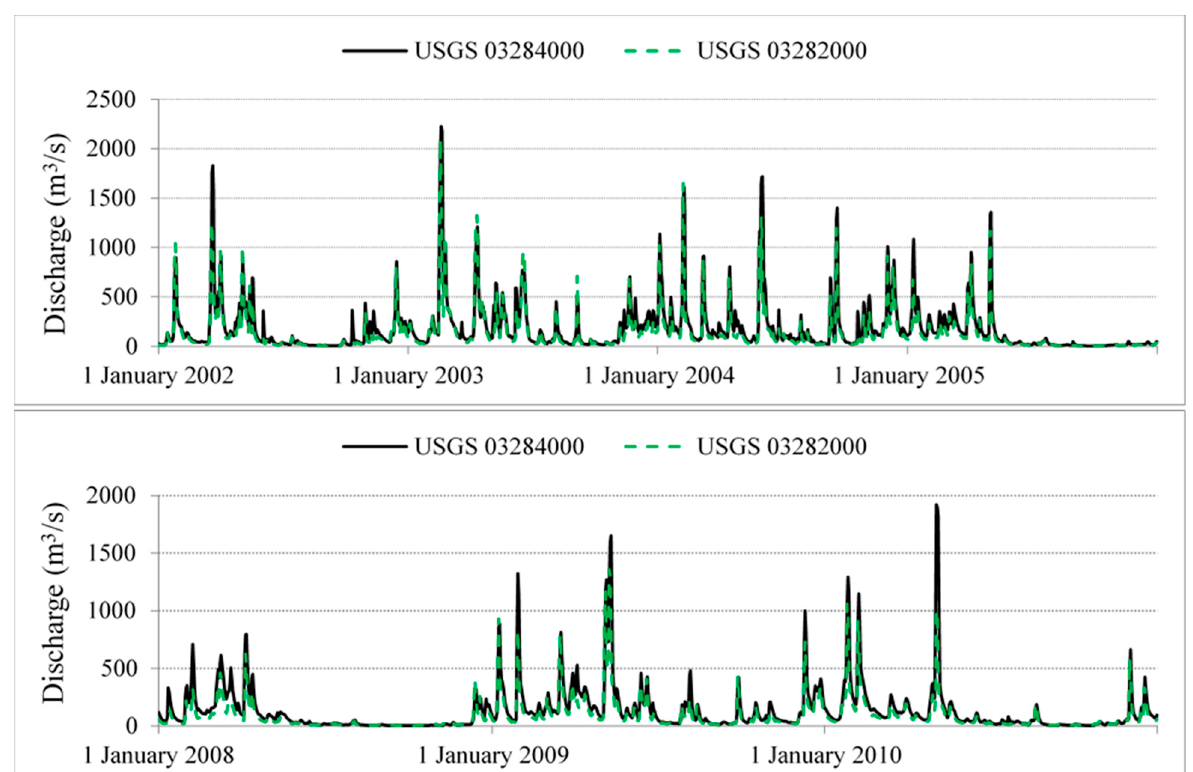
Figure 7. Daily observed discharge at USGS 03284000 and USGS 03282000 stream gauges during the 2002–2005 and 2008–2010 periods.